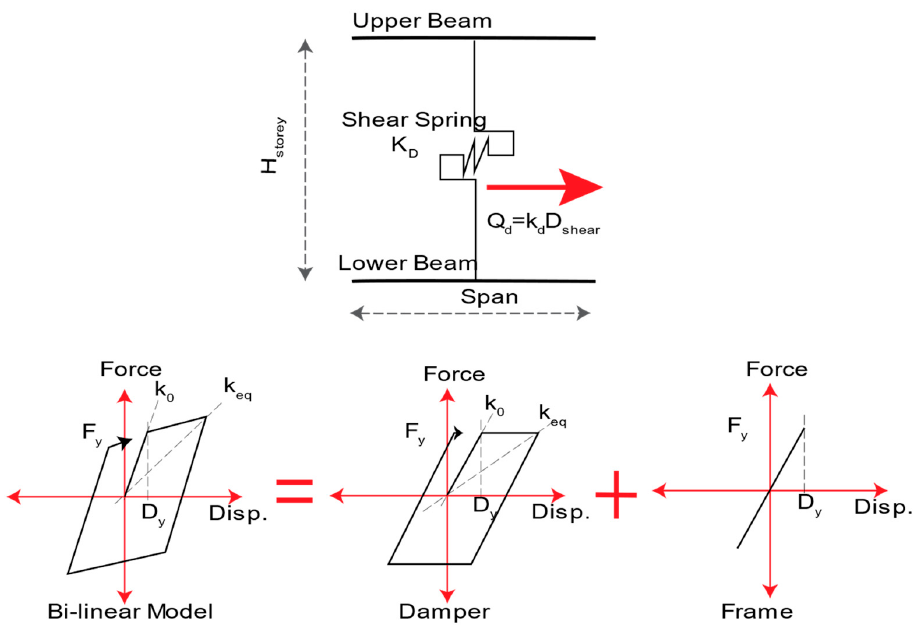
Figure 3. Configuration scheme and bilinear hysteresis model of nonlinear shear springs for BRBs.